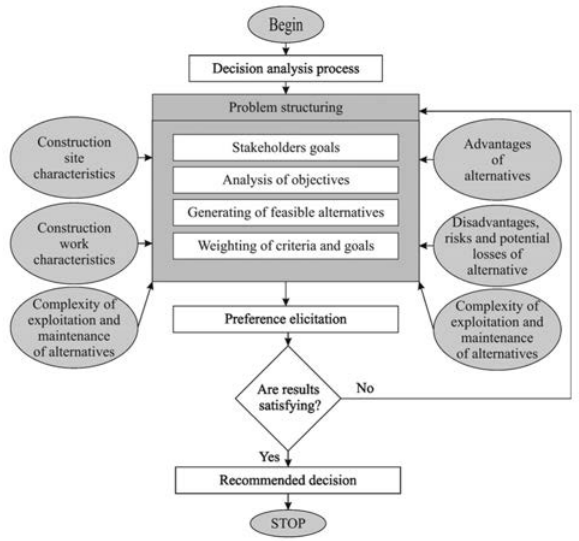
Fig. 2 . Structure of the decision support system based on the ARAS method and SWOT